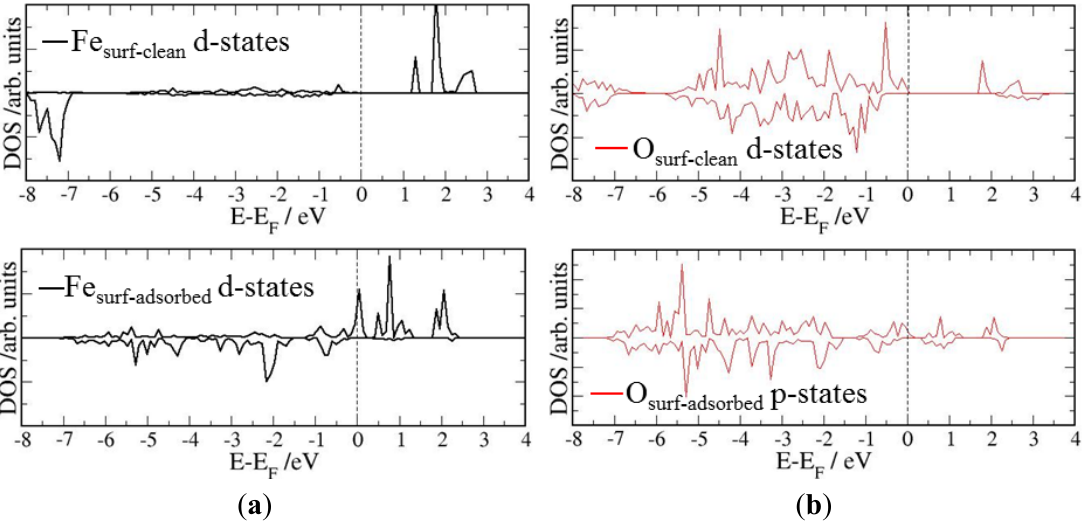
Figure 13. The electronic local density of states (LDOS) of the clean and benzene covered topmost surface ( a ) Fe and ( b ) O atoms of the α-Fe zero as shown by the dashed